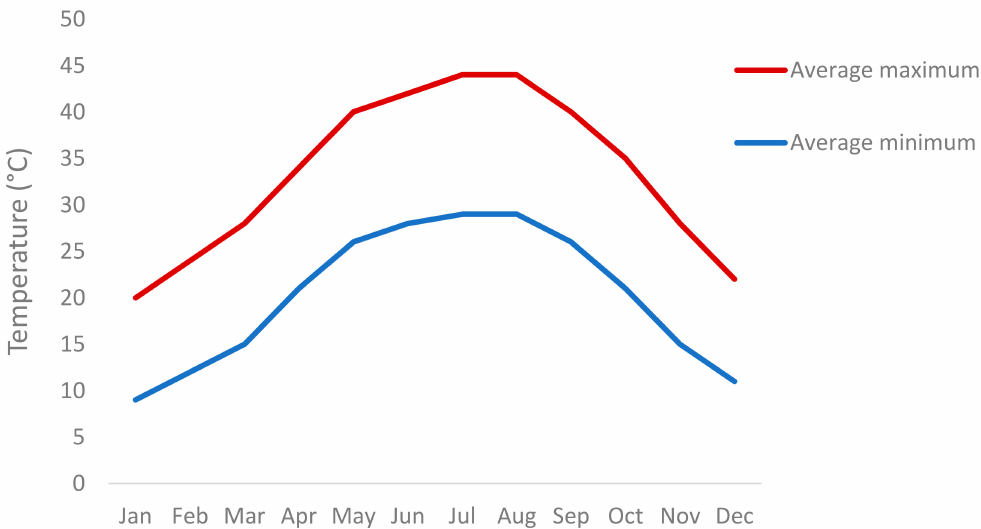
Figure 5. The average monthly maximum and minimum temperatures in Riyadh, 2017